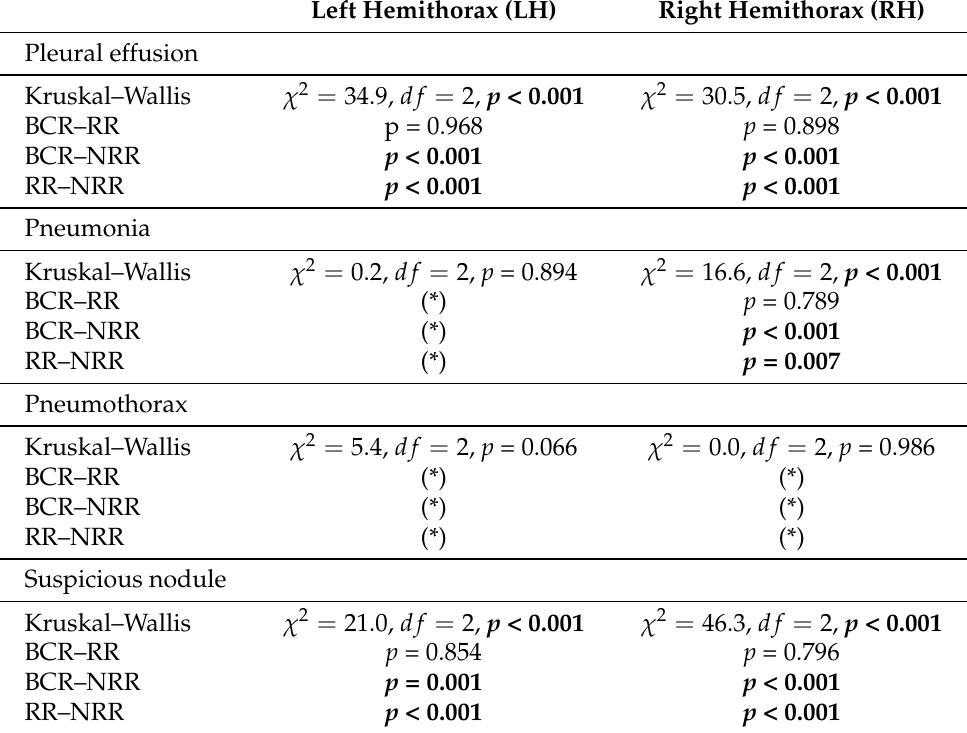
Table 1. Test results showing statistically significant differences in consensus—Tests were performed using Kruskal–Wallis one-way analysis of variance and post hoc Dunn-tests with adjusted p -Values calculated by Šidák correction. Statistically significant results ( p < 0.05) were illustrated in bold print. (*) No further post hoc test was perfomed because Kruskal–Wallis test was not statistically significant. Left Hemithorax (LH) Right Hemithorax